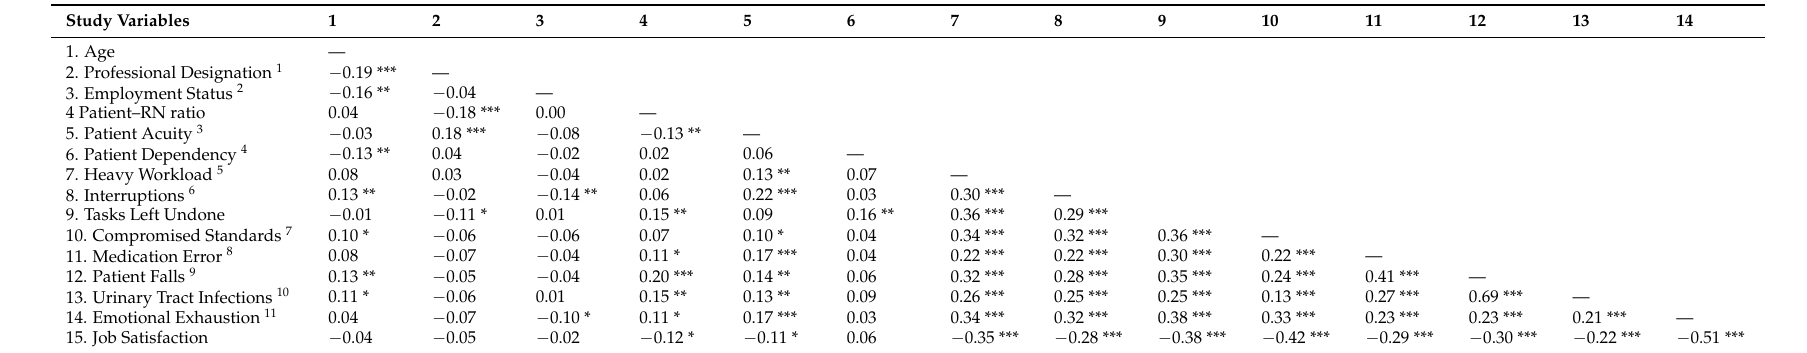
Table 3. Correlations between key study